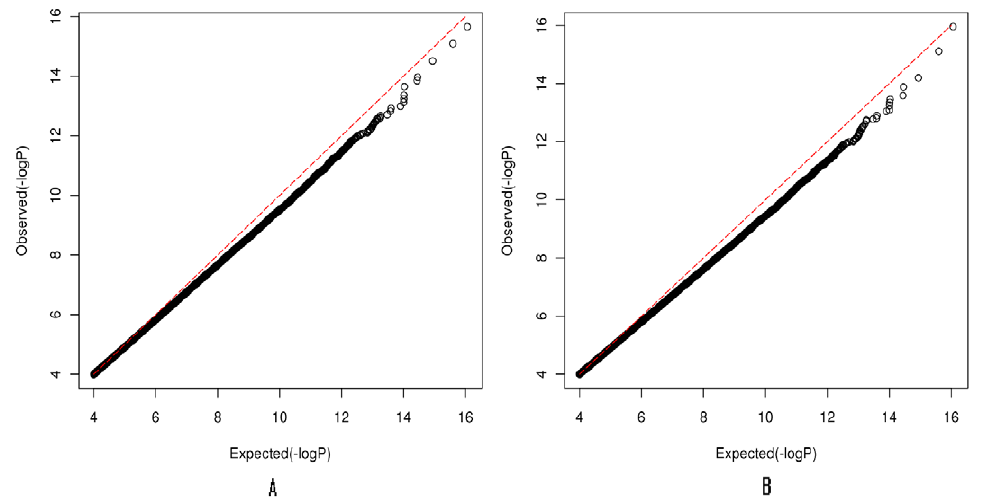
Figure 1. Quantile-quantile plots for the test statistic T IH . (A) Quantile-quantile plots for the test statistic T IH in dataset 1. The P-values ( , 1 : 0 | 10 { 4 ) for the test are plotted (as 2 log10 values) as a function of its expected p values. (B) Quantile-quantile plots for the test statistic T IH in dataset 2. The P-values ( , 1 : 0 | 10 { 4 ) for the test are plotted (as 2 log10 values) as a function of its expected p values.